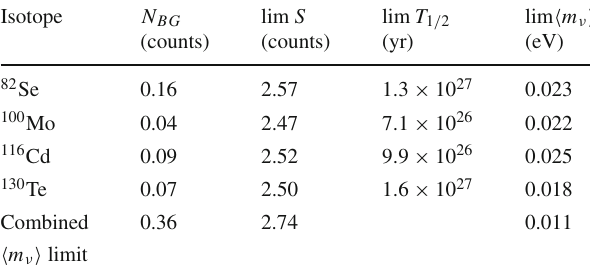
Table 5 Sensitivity of the CUPID-4 experiment with Zn 82 Se, Li 100 MoO 4 , 116 CdWO 4 and 130 TeO 2 detectors assuming a level of 2 background of 4 × 10 − 6 counts/year/kg/keV. The numbers of back- ground events in the energy intervals ≈ ± 2 σ for each detector and for the sum spectrum (last line) are denoted as N BG . The neutrino mass limits lim (cid:2) m ν (cid:3) were calculated by assuming no true signal (see discus- sion in Sect. 4.4) and assuming the matrix elements from Ref. [46], the phase space factors from Ref. [47] and the value of the axial vector coupling constant g A = 1 . 27